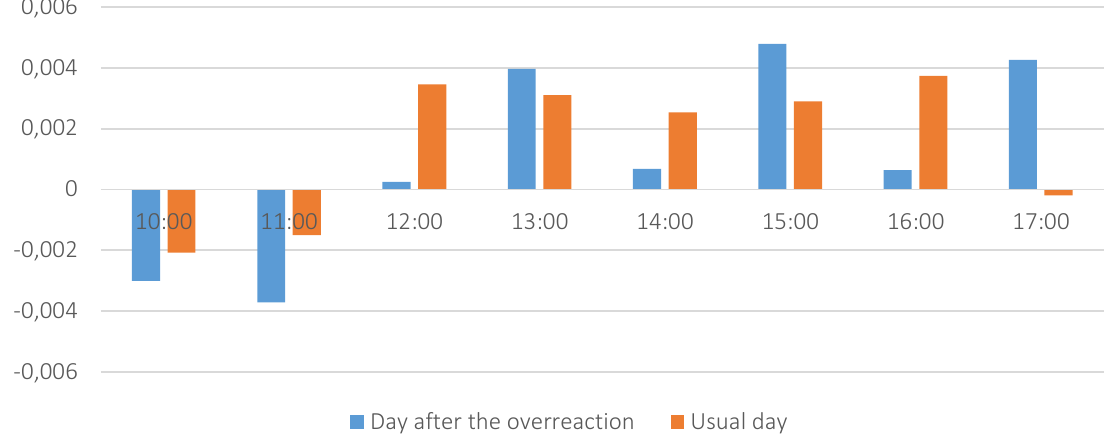
Figure 5. Average hourly returns on the day after the overreaction and normal days: the case of negative overreactions, UX-C